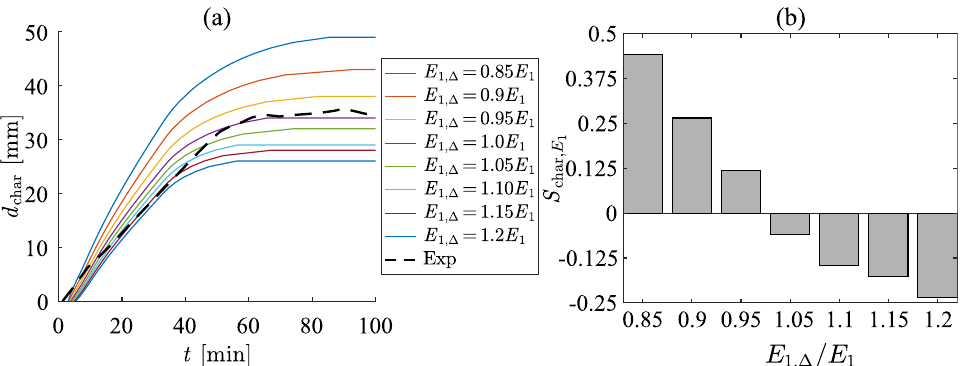
showing the influence of parameter E 1 on the final 1